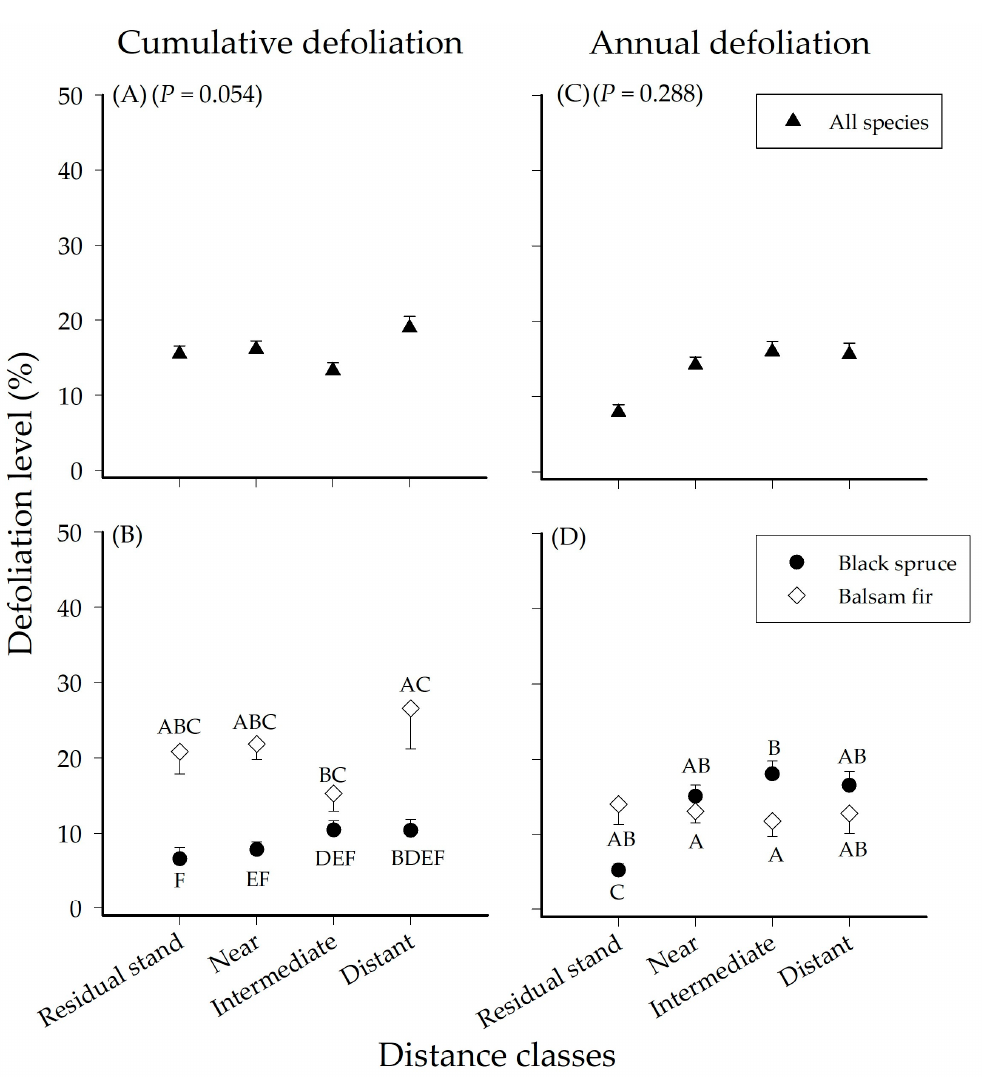
Table 3. Results of a permutational multivariate analysis of variance (PERMANOVA) for cumulative and annual defoliation among distance, species, and distance × species, including degrees of freedom (DF), sum of squares (SS), mean squares (MS), and Monte Carlo permutation test p -values ( p (MC)). Values in bold are significant.